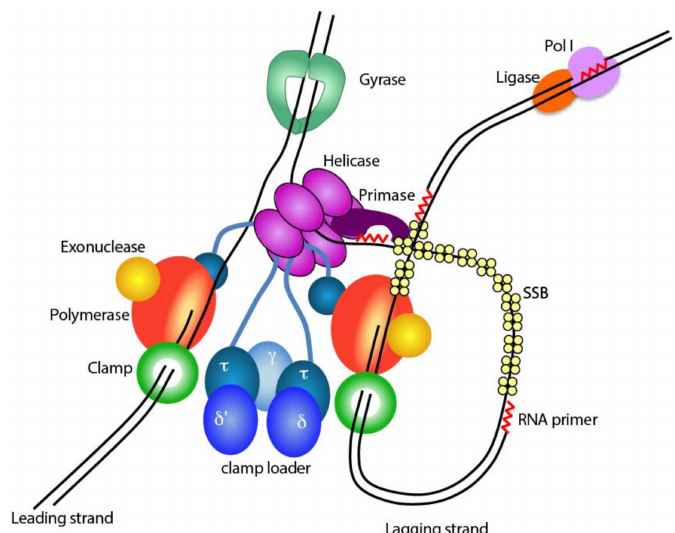
Figure 1. Schematic representation of the bacterial replisome. From top to bottom: DNA Gyrase removes positive supercoiling from the DNA that is induced by the unwinding of the two strands by the DNA Helicase. The helicase also recruits the primase that creates RNA primers for the discontinuous DNA synthesis on the lagging strand. Each of the two strands are replicated by a DNA polymerase that is bound to an exonuclease and a Clamp. The two polymerases remain connected via the clamp loader subunit τ that also binds to the helicase. The clamp loader complex comprising δ , δ (cid:48) , τ and γ subunits loads the clamp onto the RNA primers created by the primase. Single stranded DNA binding protein (SSB) tetramers coat the single stranded DNA (ssDNA) on the lagging strand, while DNA Polymerase I (Pol I) and DNA Ligase remove the RNA primer and close the